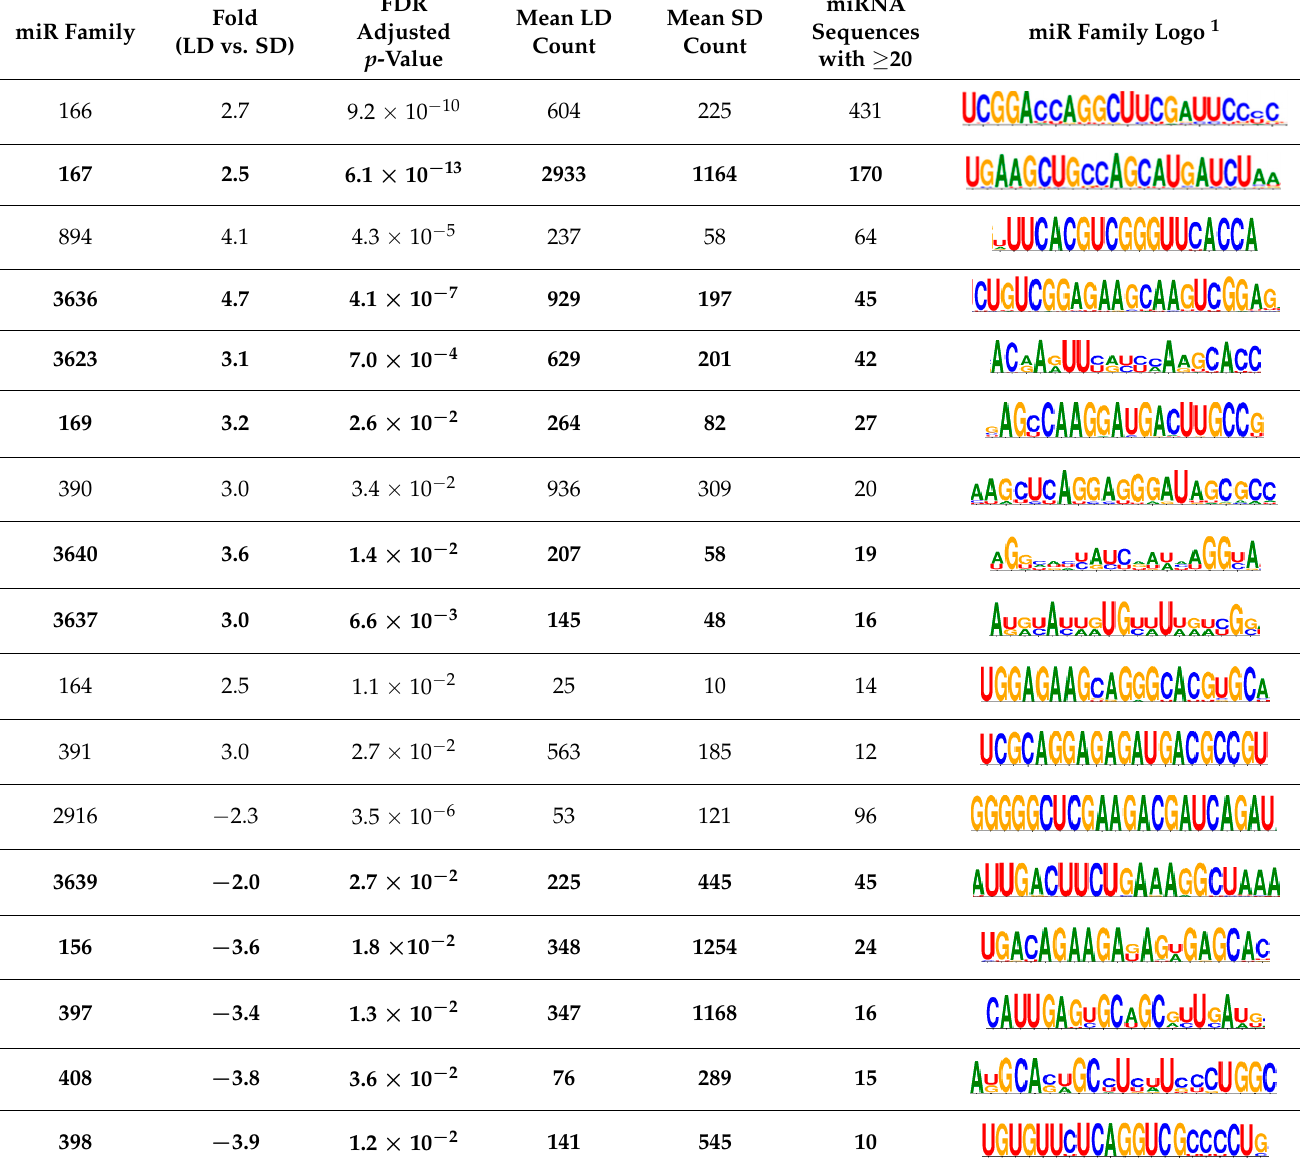
Table 1. Significant enrichment of miRNA families during paradormancy (LD, 15 h) and endodormancy induction (SD, 13 h) in V. riparia buds.